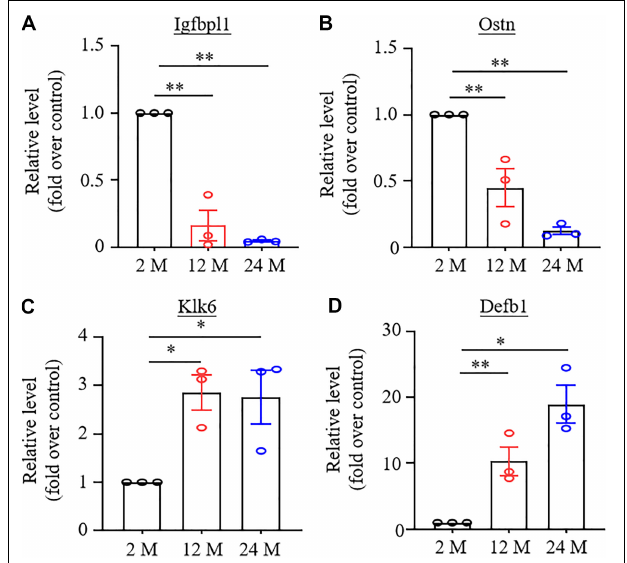
FIGURE 6 | Verification of the changes in expression of some differentially expressed genes using real-time reverse transcription polymerase chain reaction (RT-PCR) analysis. N = 3 biological repeats (3 mice)/age. Data were shown as mean ± SEM. (A,B) Expression of Igfbpl1 mRNA in the hippocampus (A) and Ostn mRNA in ACC (B) were significantly reduced in both 12- and 24-month old mice as compared to 2-month old mice. ∗∗ P < 0.01 versus the corresponding 2-month old mice by one-way ANOVA with repeated measures followed by post hoc Tukey test. (C,D) Expression of Klk6 mRNA in amygdala (C) and Defb1 mRNA in ACC (D) were significantly increased in 12- and 24-month old mice as compared to 2-month old mice. ∗ P < 0.05, ∗∗ P < 0.01 versus 2-month old mice by one-way ANOVA with repeated measures followed by post hoc Tukey